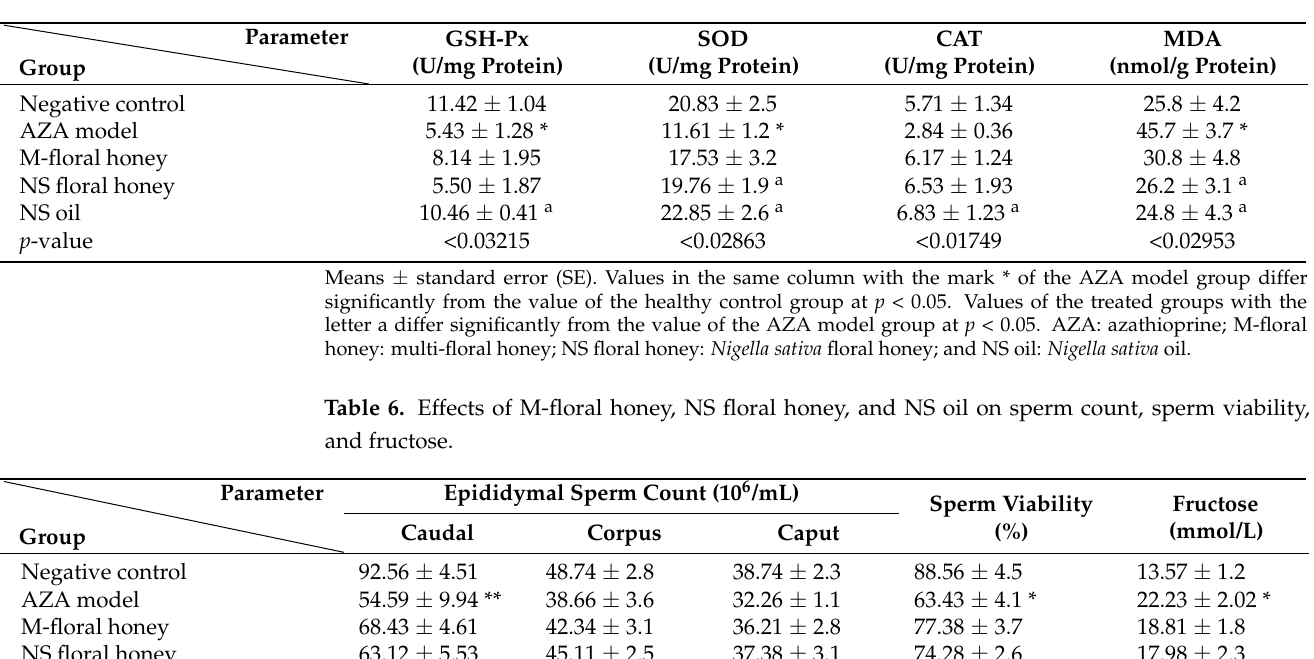
Testes of positive control model rats administered AZA revealed marked degeneration and necro- sis of spermatogonia cells lining seminiferous tubules (black arrow) and interstitial edema (red arrow) ( C ) and marked degeneration and necrosis of spermatogonia cells lining seminiferous tubules (black arrow) associated with spermatid giant cell in the lumen (blue arrow) and interstitial edema (red arrow) ( D ). Testes of rats administered M-floral honey revealed the formation of spermatid giant cells in the lumen of the seminiferous tubule (arrow) ( E ) and necrosis of some Leydig cells (arrow) ( F ). Testes of rats administered NS floral honey demonstrated necrosis and sloughing of some spermatogonia cells lining some seminiferous tubules (arrow) ( G ), whereas other sections revealed